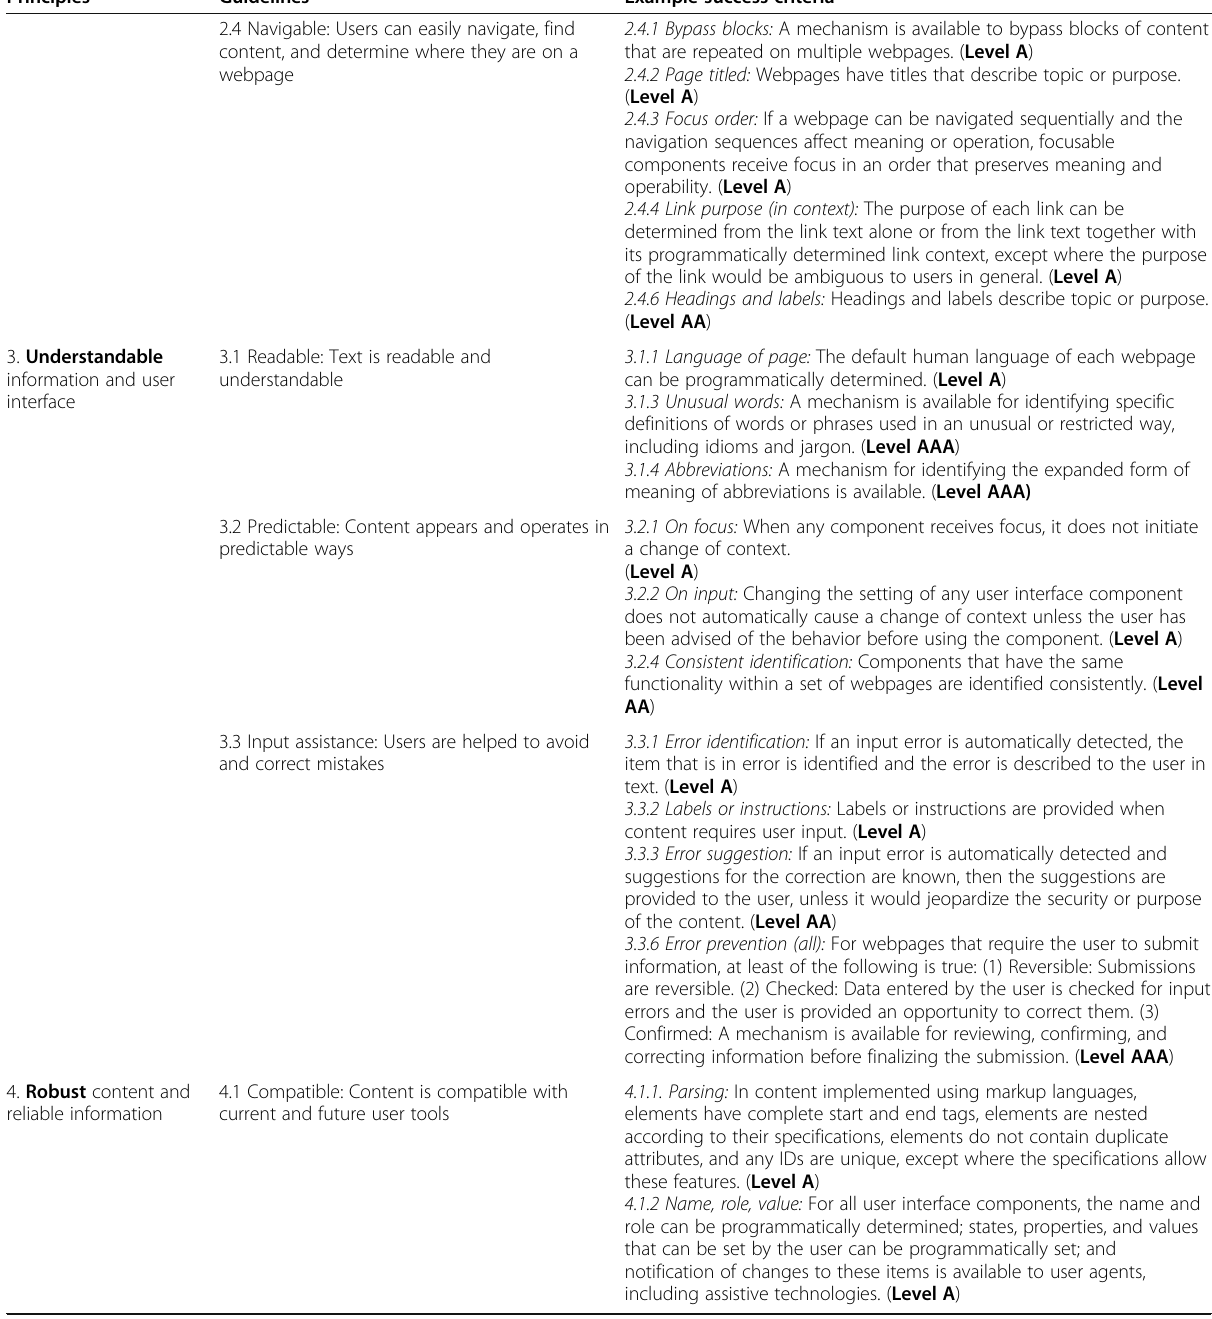
Table 5 Web Content Accessibility Guidelines (WCAG) principles, guidelines, and examples of success criteria and their levels (Note: this is not an exhaustive list)